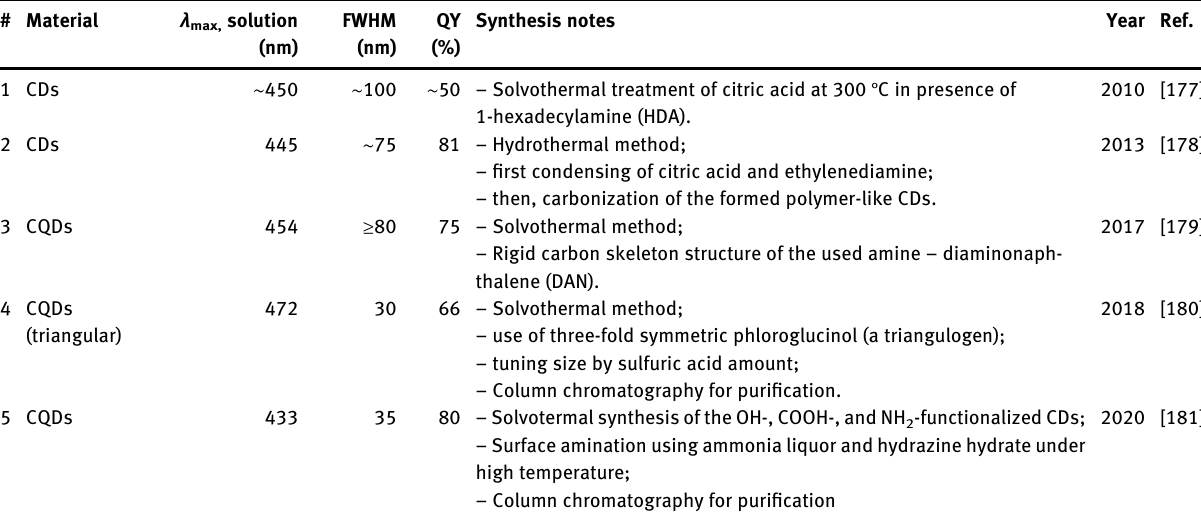
Table  : Blue-emitting carbon dots and quantum dots, their PL performance and synthetic